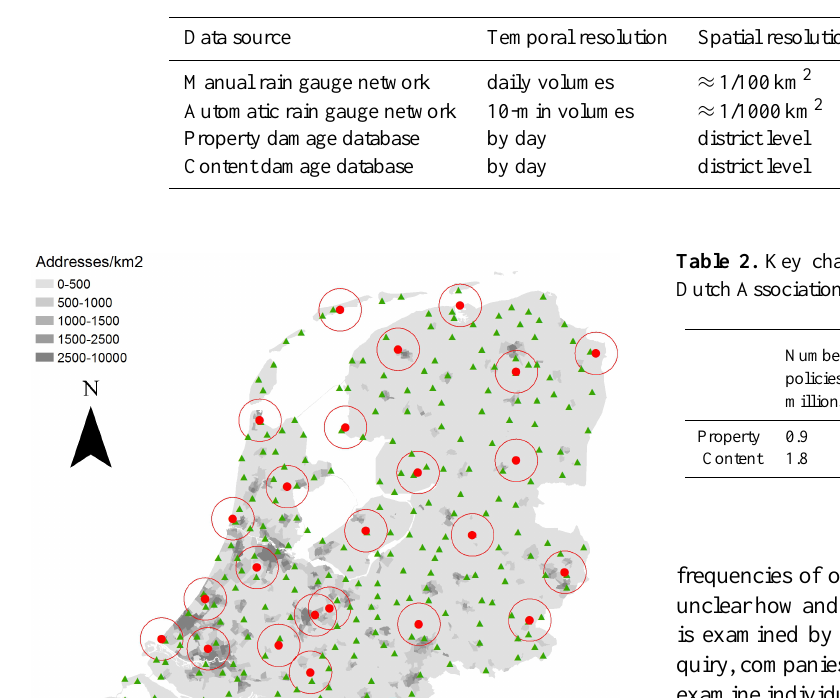
Table 1. Summary of rainfall and insurance data sources.